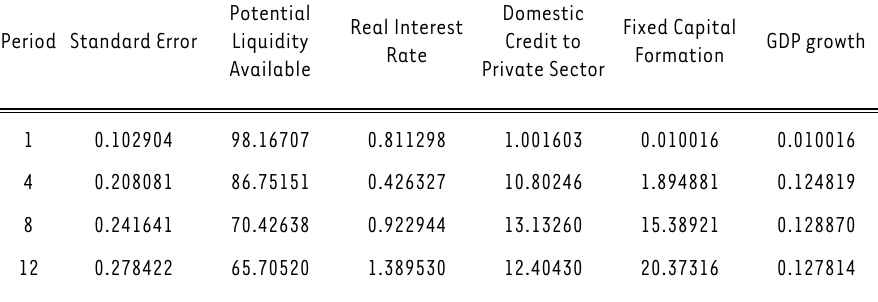
TABLE 5: Variance decomposition Variance decomposition of potential liquidity available Period Standard Error